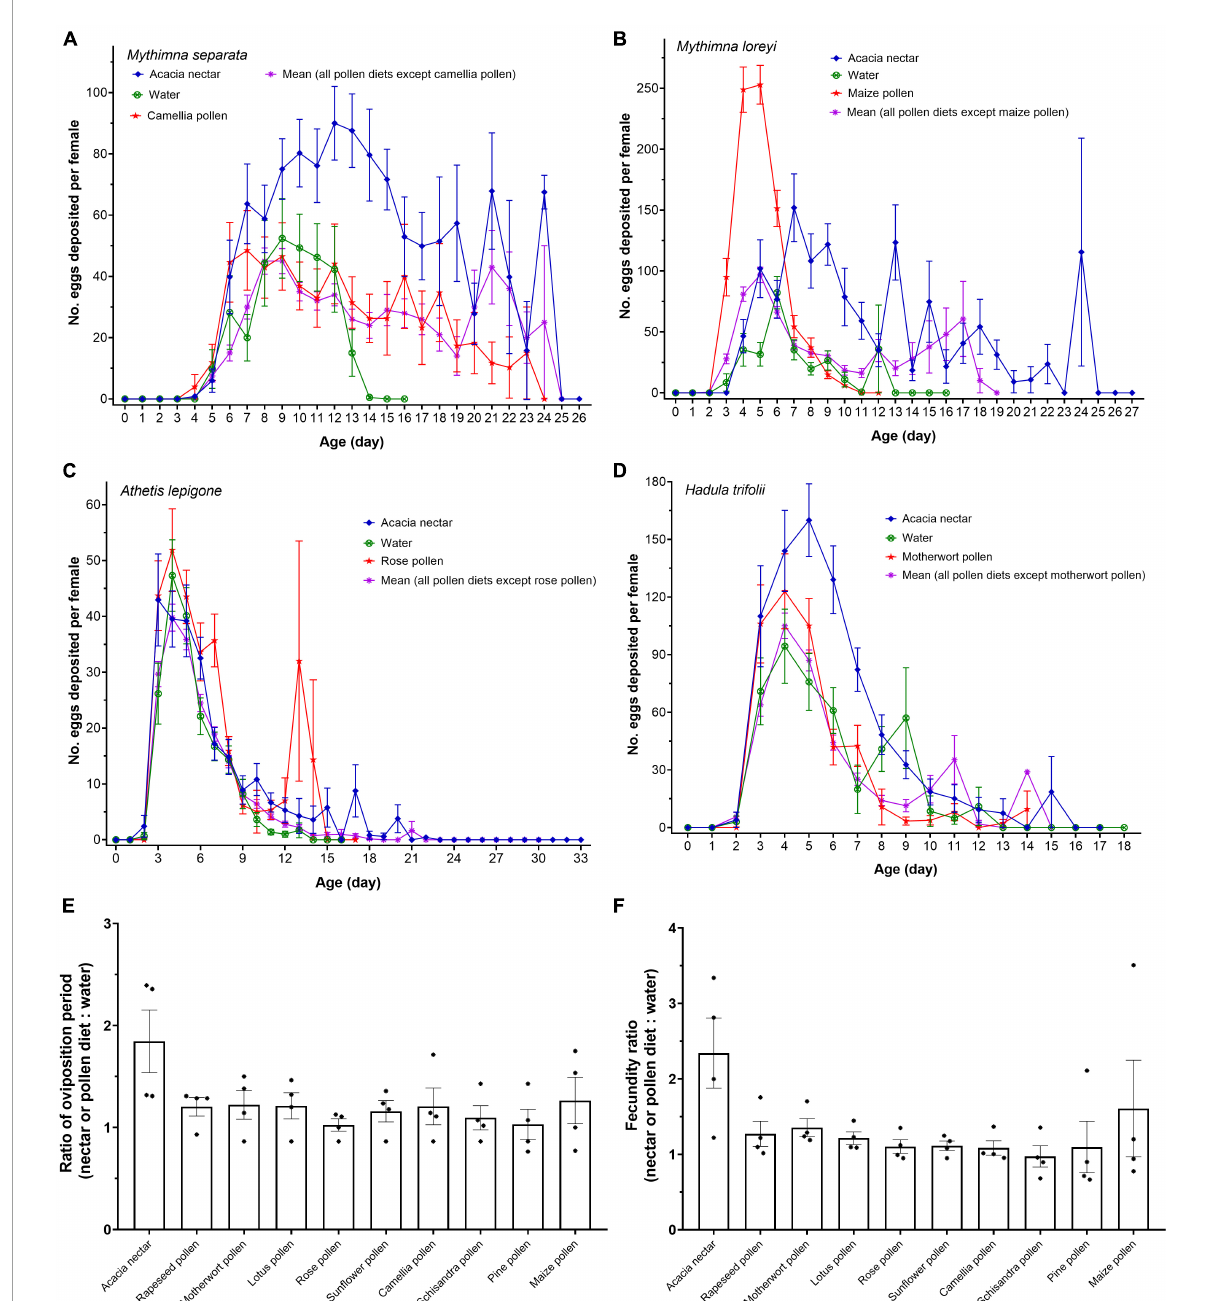
FIGURE4 Mean ( ± SE) daily average fecundity curves of female adults of Mythimna separata (A) , Mythimna loreyi (B) , Athetis lepigone (C) and Hadula trifolii (D) and the ratio of oviposition period (E) and fecundity (F) for females on different diets. Asterisks for each diet indicate the actual ratio for each species of noctuid